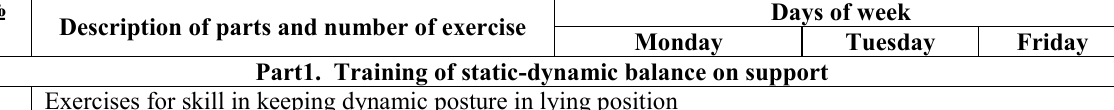
Exercises for skill in keeping dynamic posture in lying